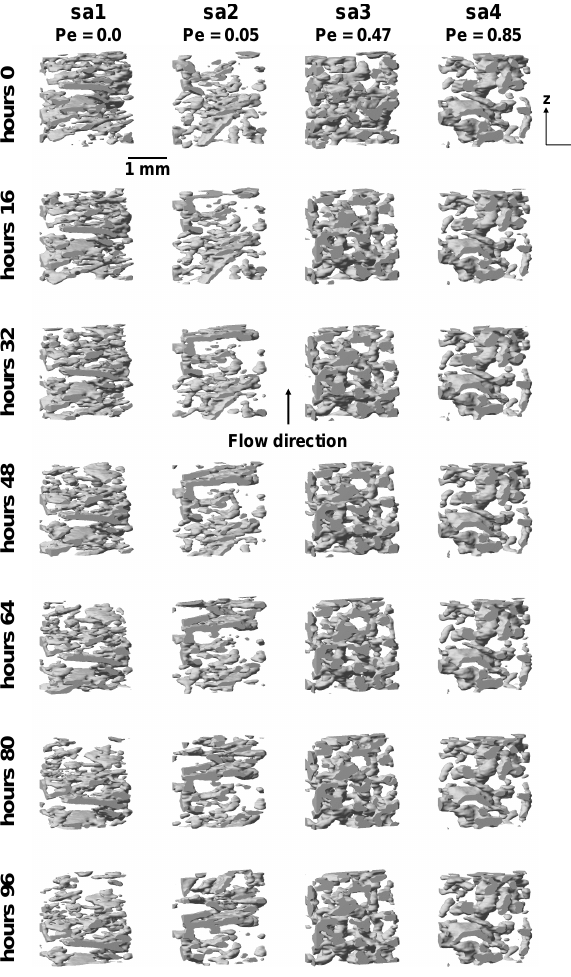
Figure 4. Evolution of the 3-D structure of the ice matrix during isothermal metamorphism under advective conditions. Experimen- tal conditions (from left to right) at different measurement times from beginning to the end (top to bottom) of the experiment. The shown cubes are 110 × 42 × 110 voxels (2mm × 0 . 75mm × 2mm) large.